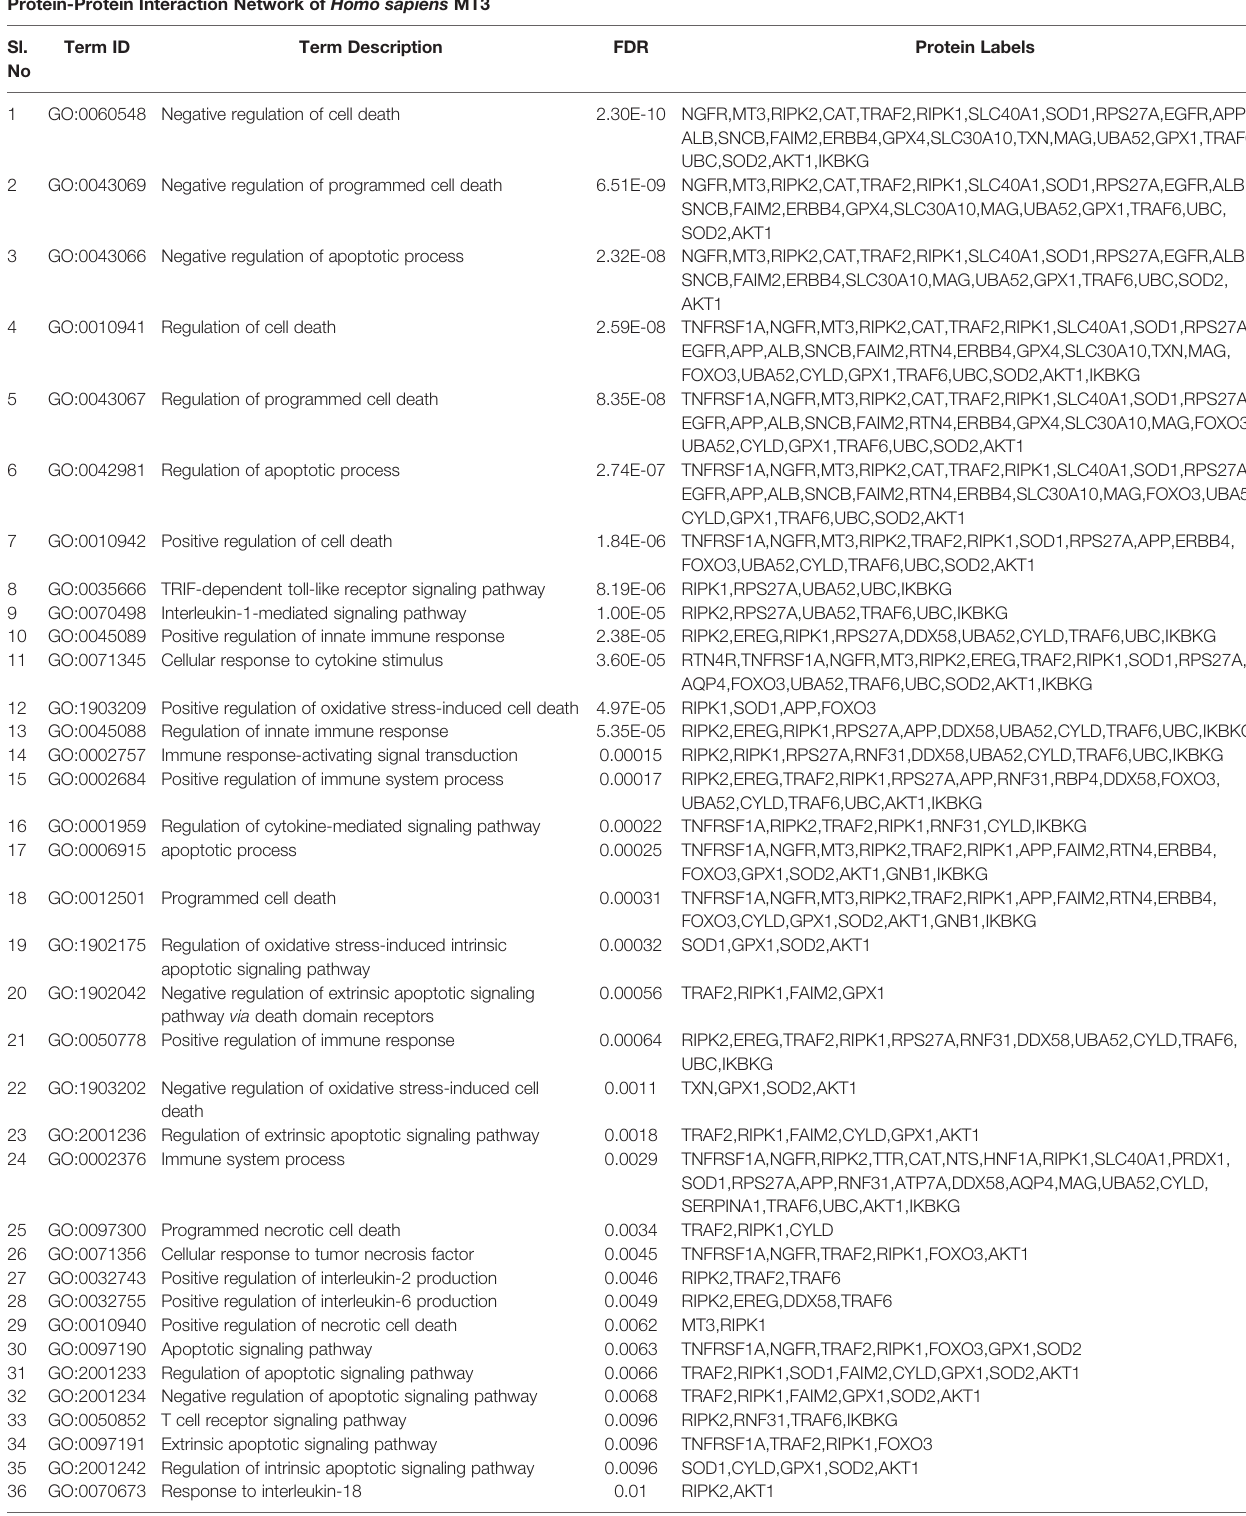
TABLE 1 | See also Supplementary Table S1 and Files S1 , S2 |Protein interaction network of Mus musculus MT3 to determine functionally enriched GO BP categories using the STRING database. Protein-Protein Interaction Network of Homo sapiens